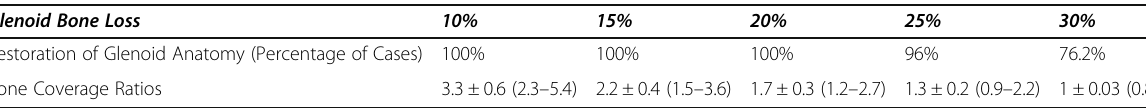
Table 2 Overall results according to Glenoid Bone Loss Glenoid Bone Loss 10% Restoration of Glenoid Anatomy (Percentage of Cases) 100%